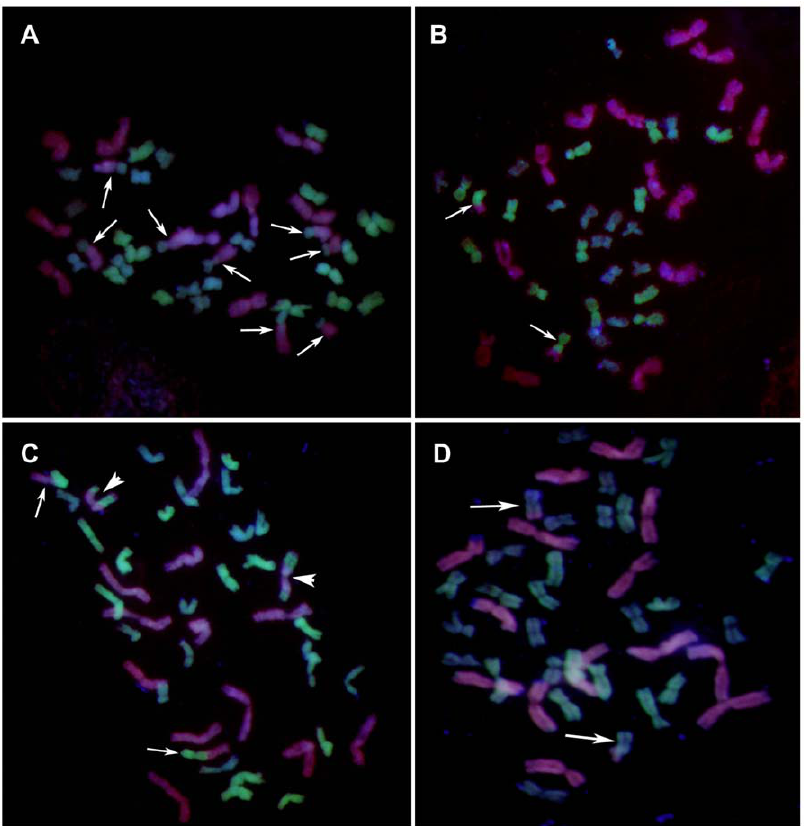
Figure 1. Chromosome translocations of St, P and Y genomes in K.thoroldiana . St genome DNA signal is green, P genome DNA signal is red, and blue indicates no hybridization signal. (A) One individual in population Z2538: four pairs of P/Y whole-arm reciprocal translocations (arrow). (B) One individual in population Z2544: two P/St terminal translocations (arrow), 15 P chromosomes and 12 St chromosomes. (C) One individual in population Z2628: one pair of P/St terminal reciprocal translocations (arrow) and one pair of P/St terminal + intercalary reciprocal translocations (arrowhead). (D) One individual in population Z2628: two P/Y terminal translocations (arrow), 14 P chromosomes and 12 Y chromosomes.